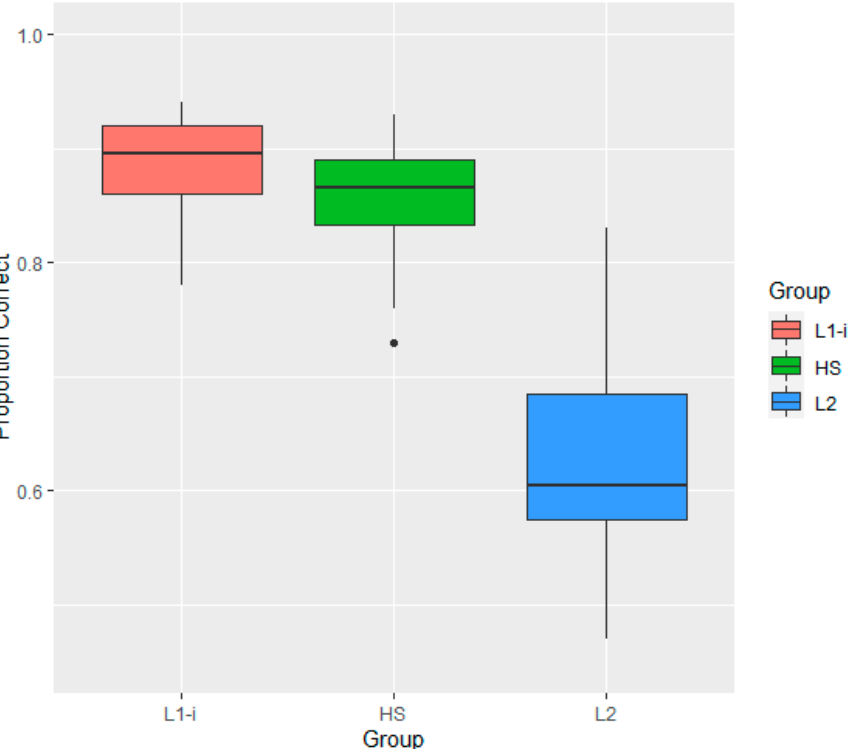
Languages 2022 , 6 , x FOR PEER REVIEW Figure 2. Boxplots showing the average perceptual accuracy by group in the AX discrimination task.